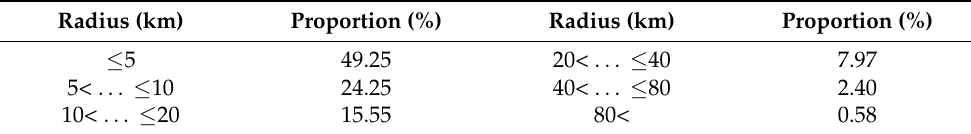
Table 2. The distribution of craters on the near